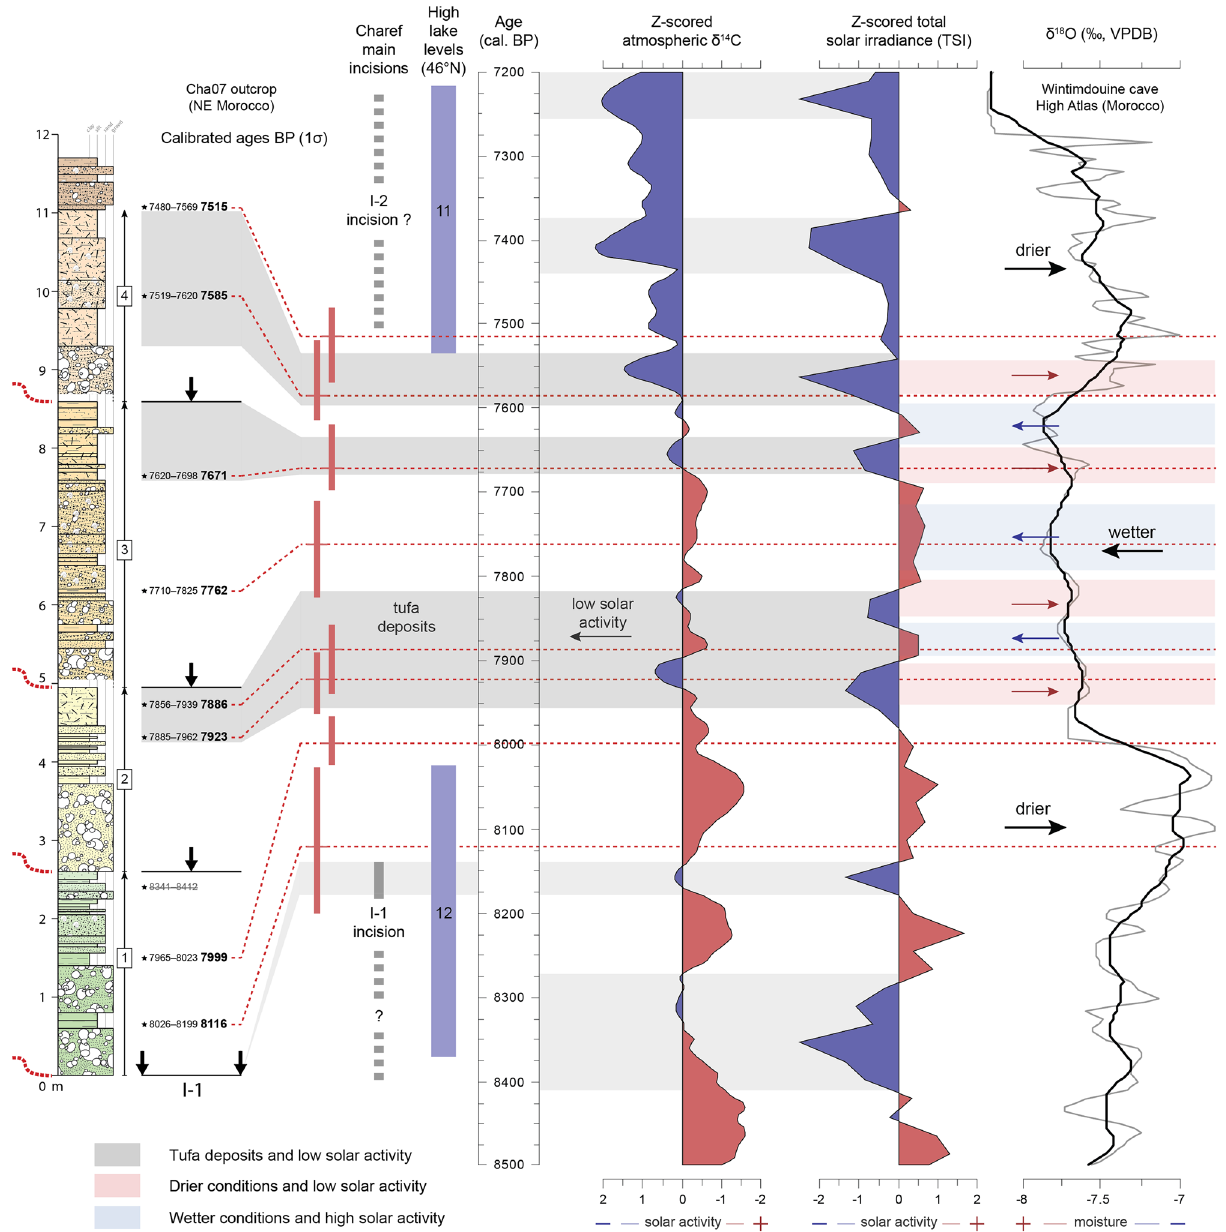
Figure 8. Comparison of the Charef record with mid-European high lake levels 38 , the speleothem record from the Wintimdouine cave in the High Atlas 14 (δ 18 O values in grey, and moving average over 13 points following a 5-year resampling in black using Analyseries software), and the main solar proxies: Z-scored δ 14 C values 52 and total solar insolation (TSI, W m −2 ) derived from 14 C and 10 Be radionuclides 37